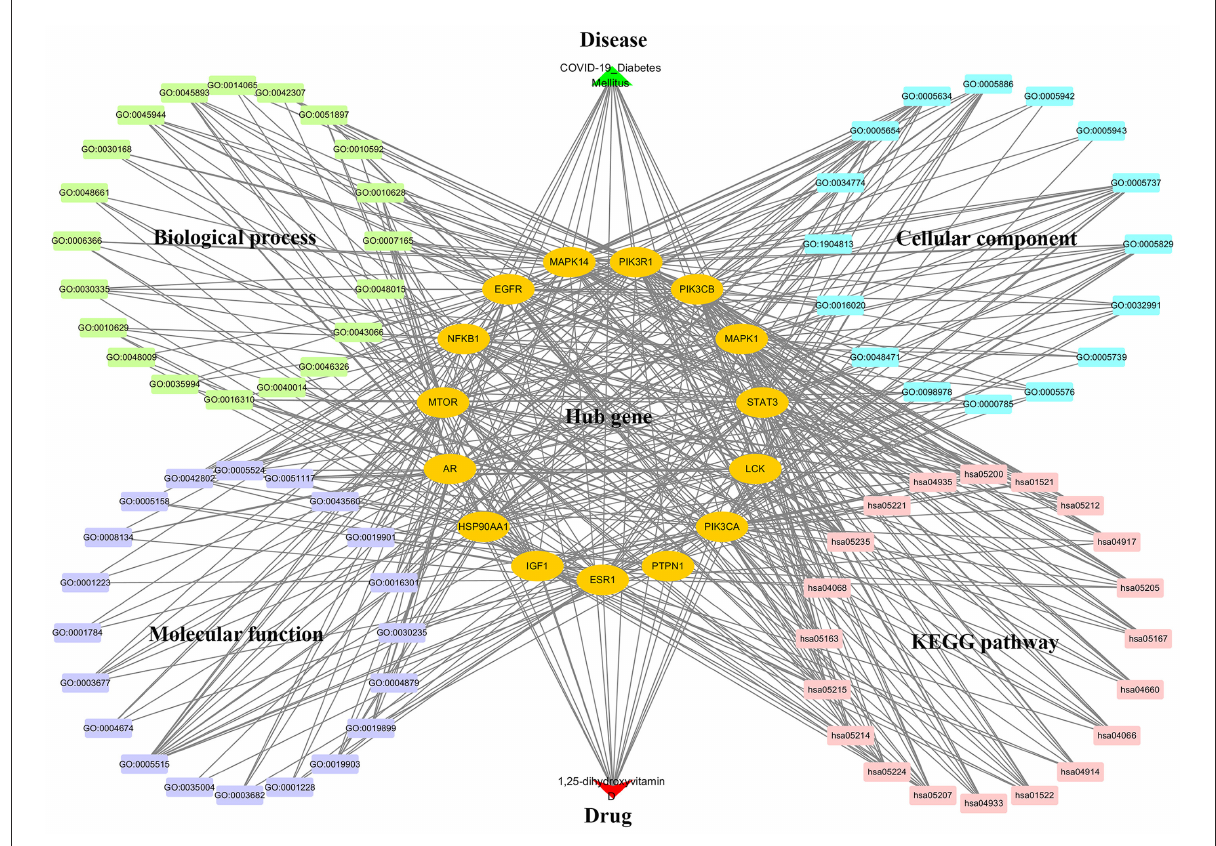
FIGURE7 1,25-dihydroxyvitamin D–targets–GO and KEGG pathways–COVID-19/DM network diagram.